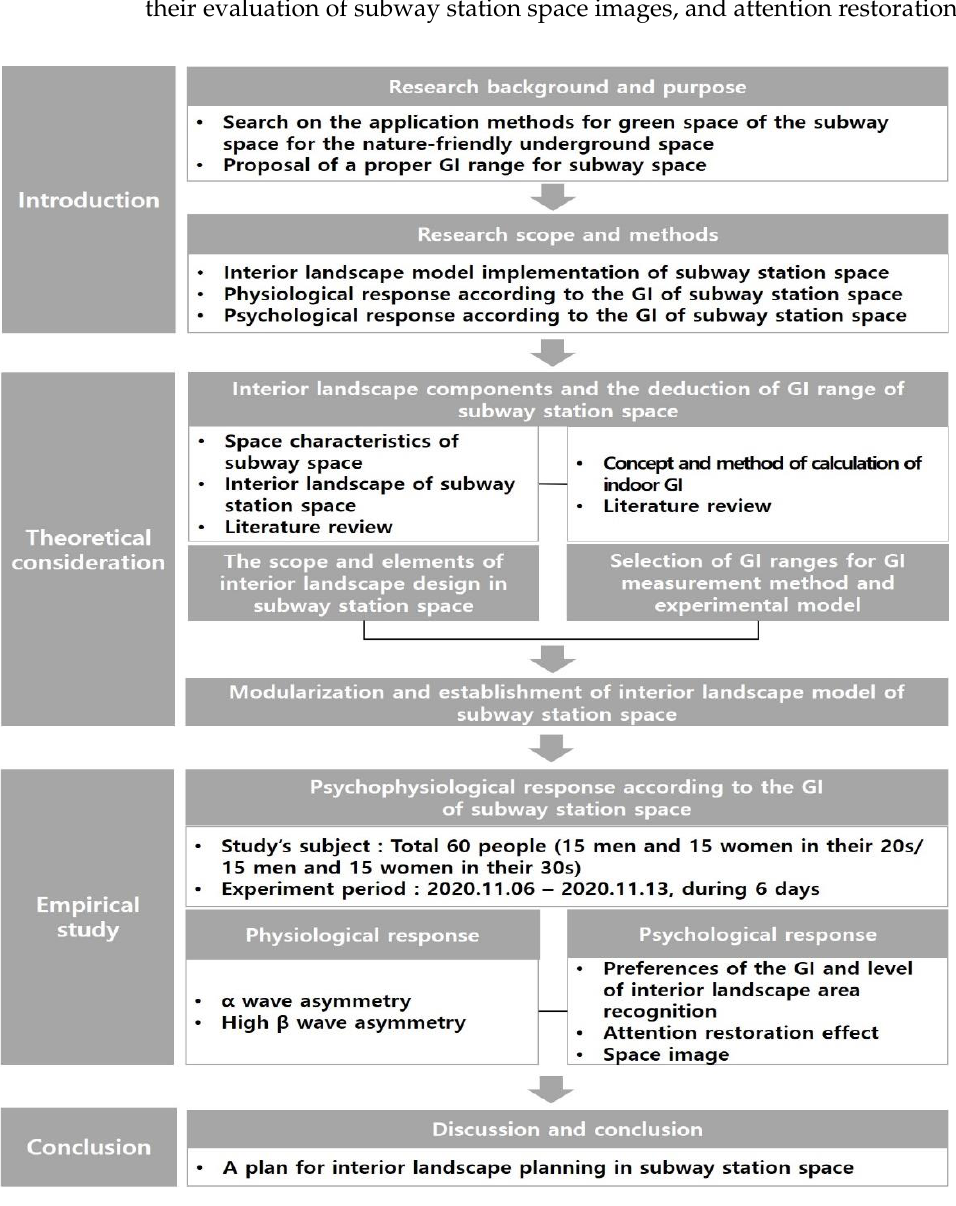
Figure 1. Research Flow of Study.